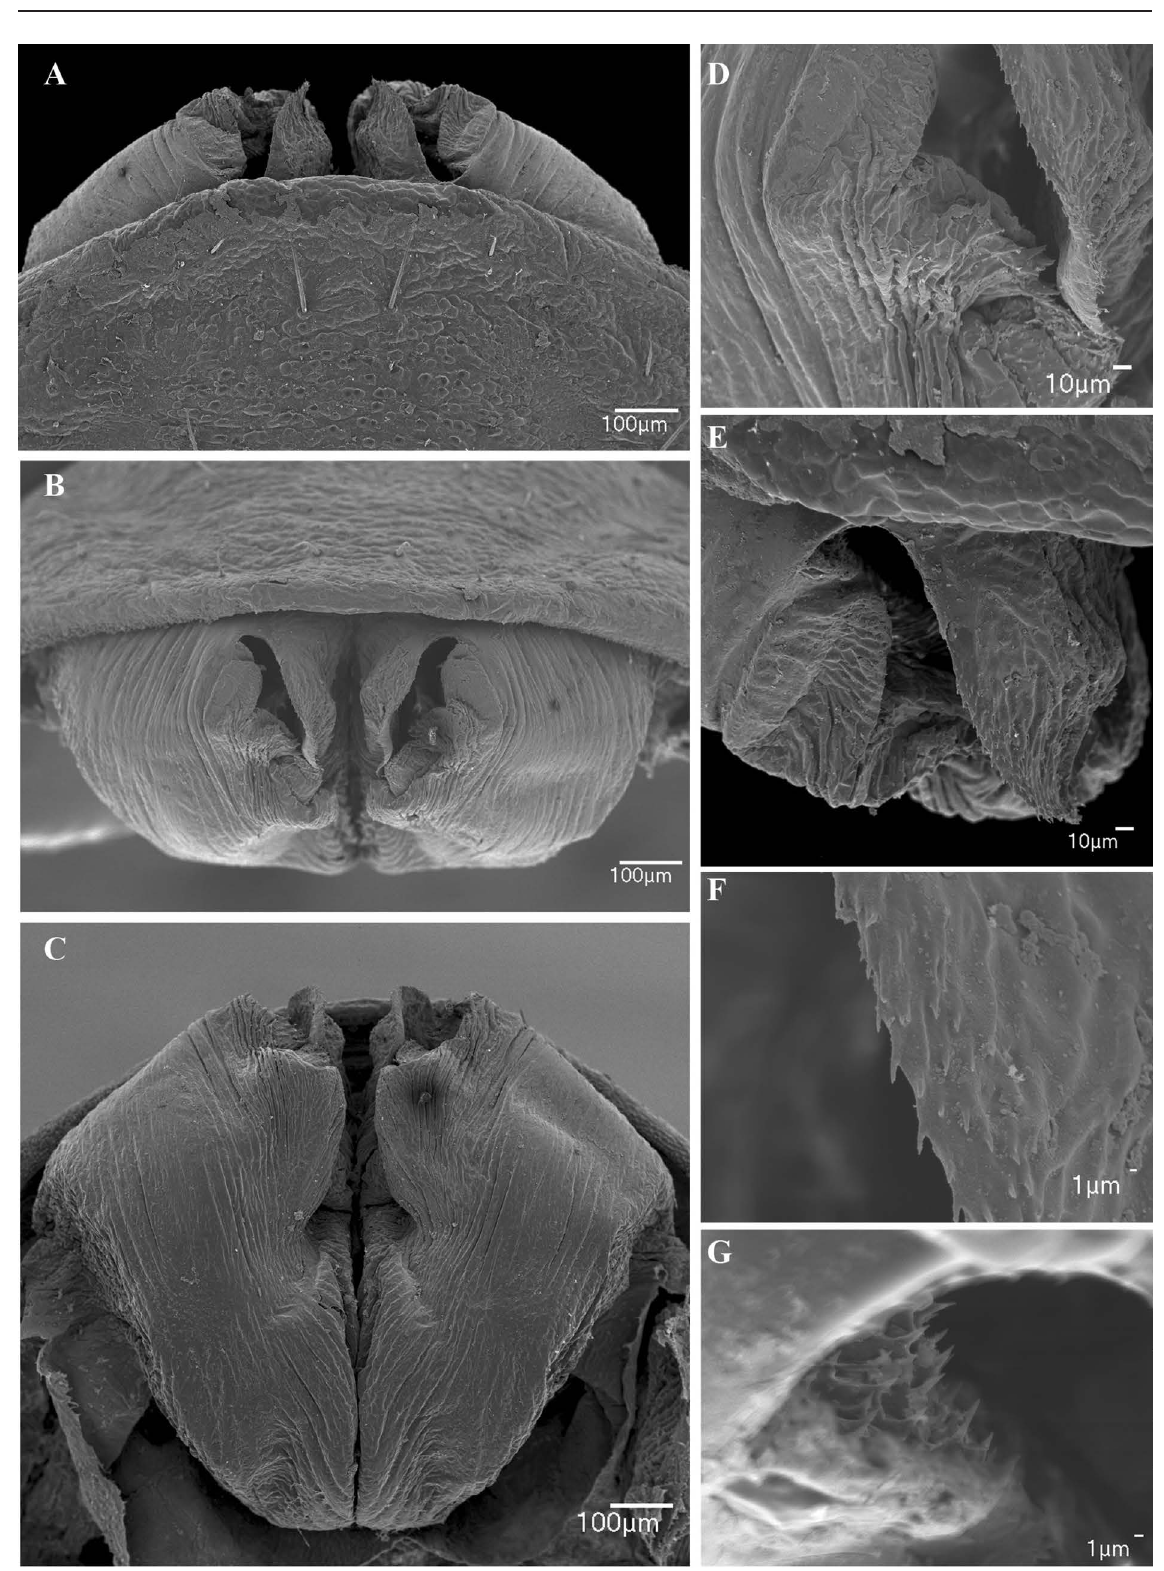
Fig. 139. Sarax bispinosus (Nair, 1934) (AMNH), male gonopod. A . Ventral view. B . Posterior view. C . Dorsal view. D . Sinistral side of gonopod. E . Lamina medialis. F . Margin of lamina medialis. G . Internal surface of fistula with spiny